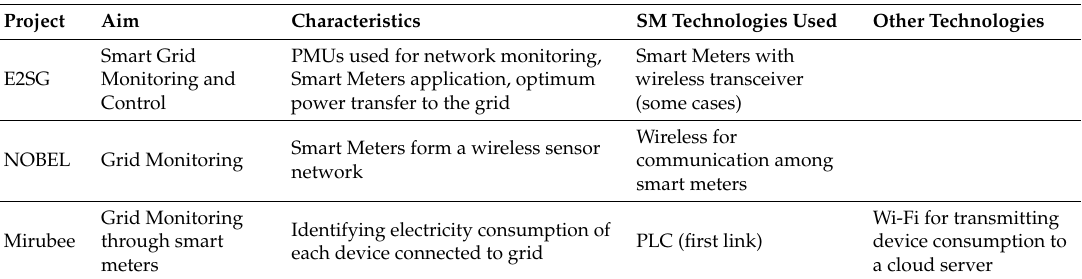
Table 4. Summary of projects for Grid Monitoring and Control through Smart Metering and their main